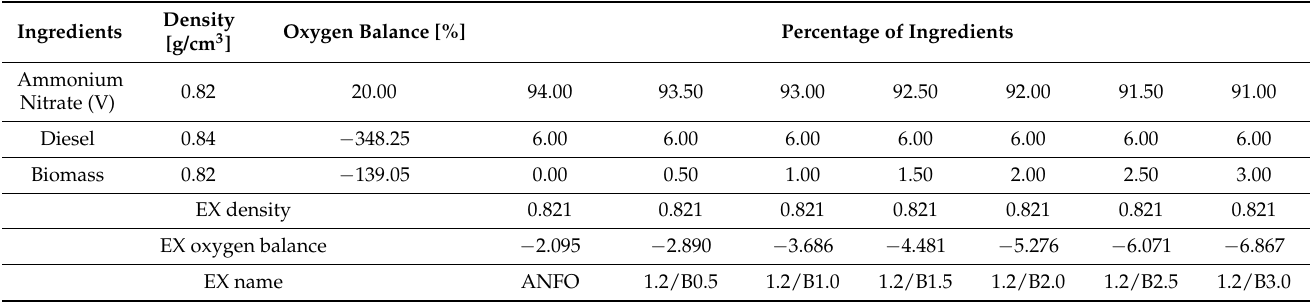
Table 2. Oxygen balance and EX density of ANFO type with addition of biomass for variant